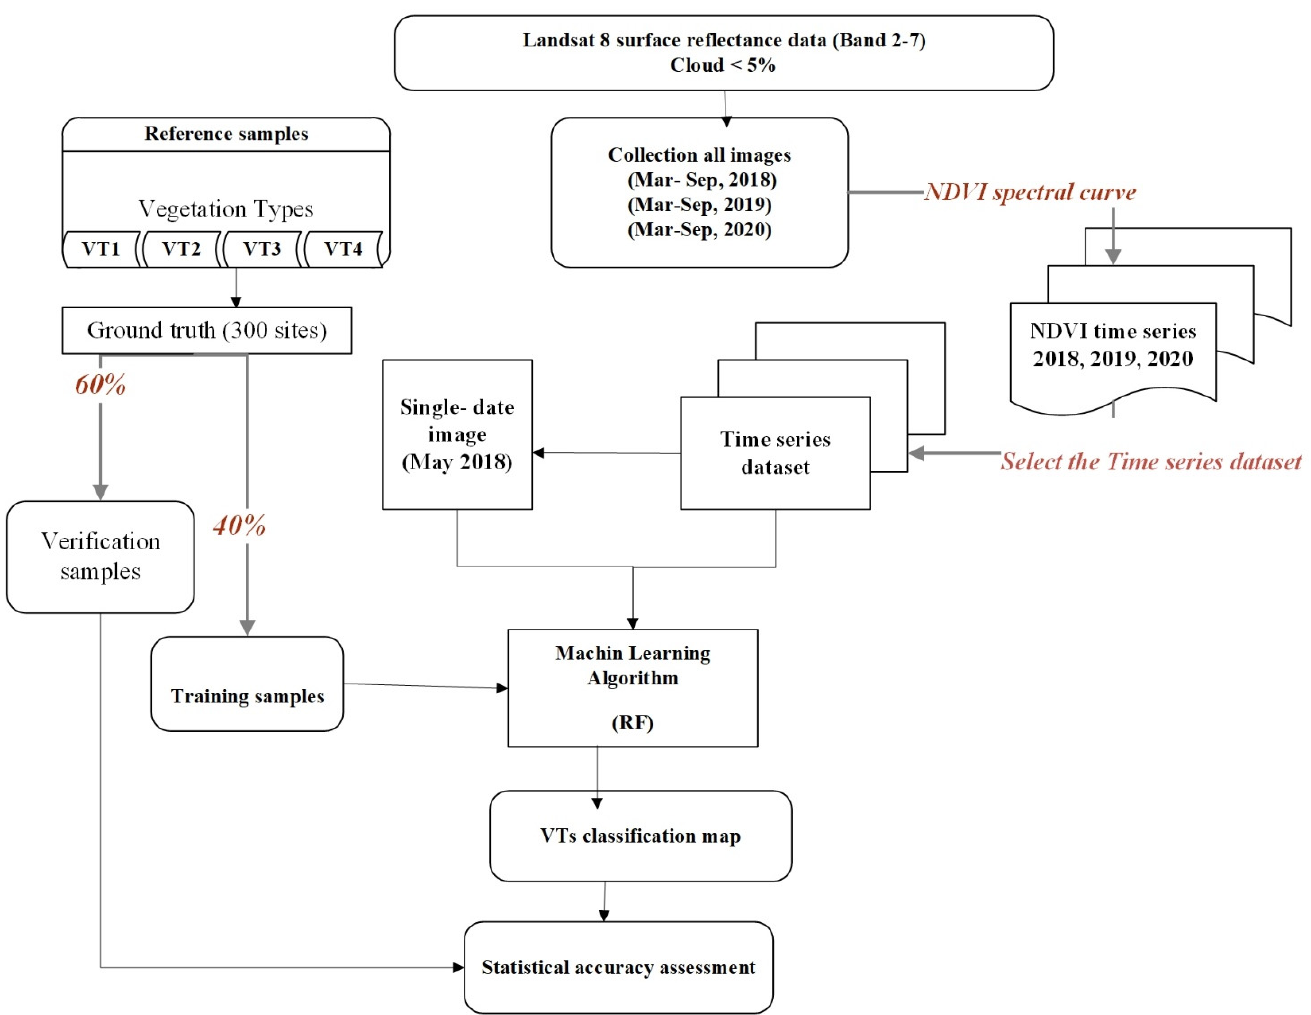
Figure 4. Workflow of VTs classification through selecting the optimal collection multi-temporal images with the RF classification algorithm.